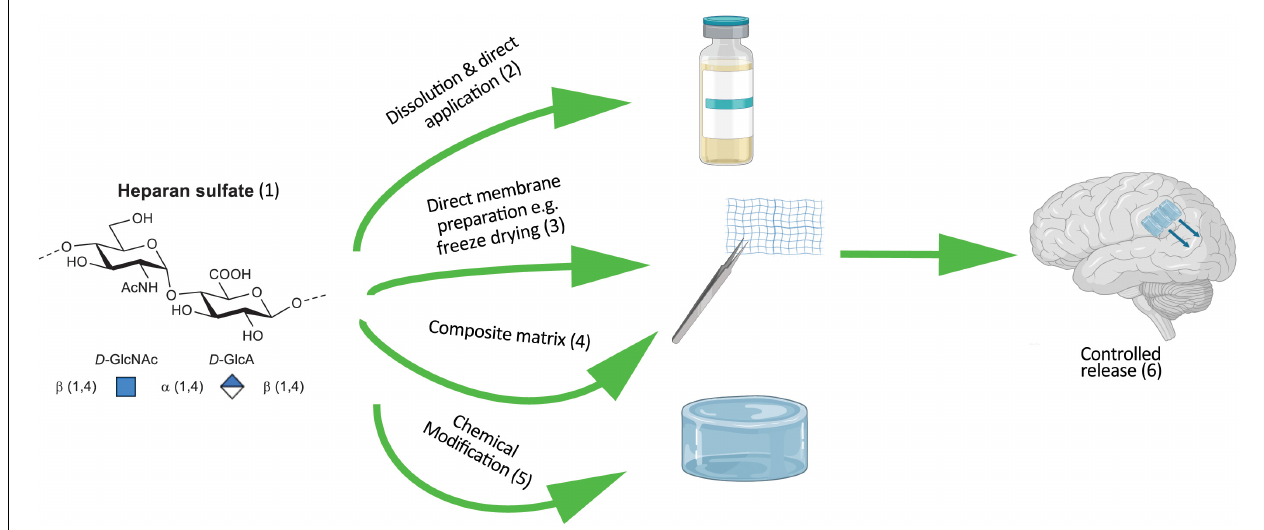
FIGURE 3 | Schematic of incorporating HS into therapeutic devices. (1) Synthetic HS that approximates the degree of sulfation and acetylation of naturally occurring HS can be derived from heparin through chemical modifications. Example modifications of HS and composition of device. (2) HS adsorbed onto a collagen membrane. (3) Solid form of HS as a carbohydrate foam. (4) Electrostatically bound HS (net –ve charge) protein substrate (net +ve charge). (5) Pegylated, alkylated or alternative chemical modification of HS to control hydrophobicity and release for direct coating onto a device. (6) Device characteristics tuned to release HS into the extracellular matrix facilitating tissue